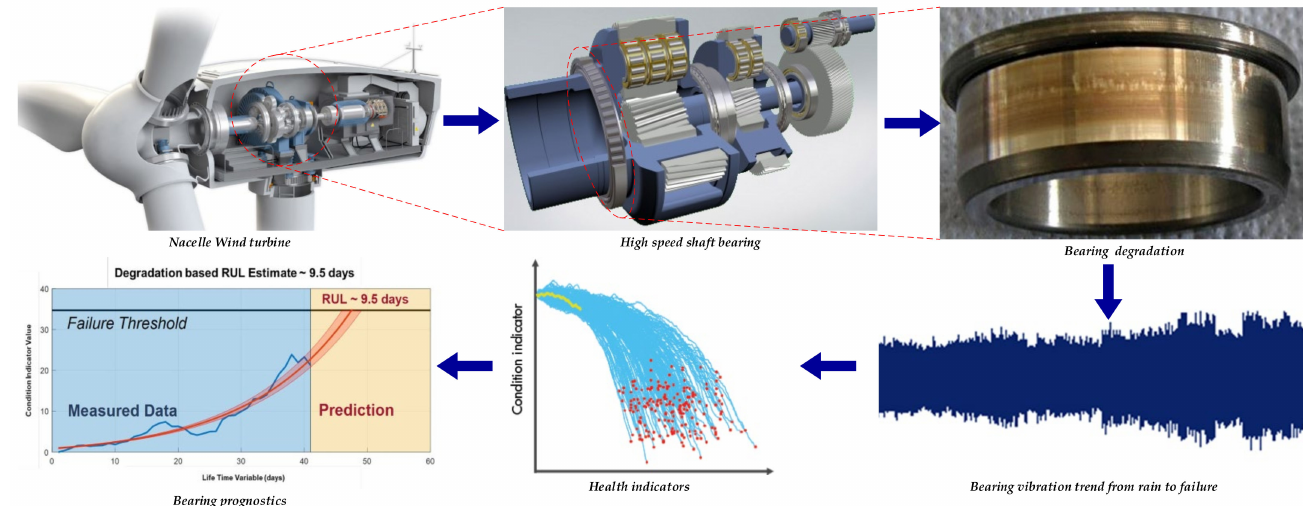
Figure 11. Experimental setup for HSSB wind turbine prognosis.